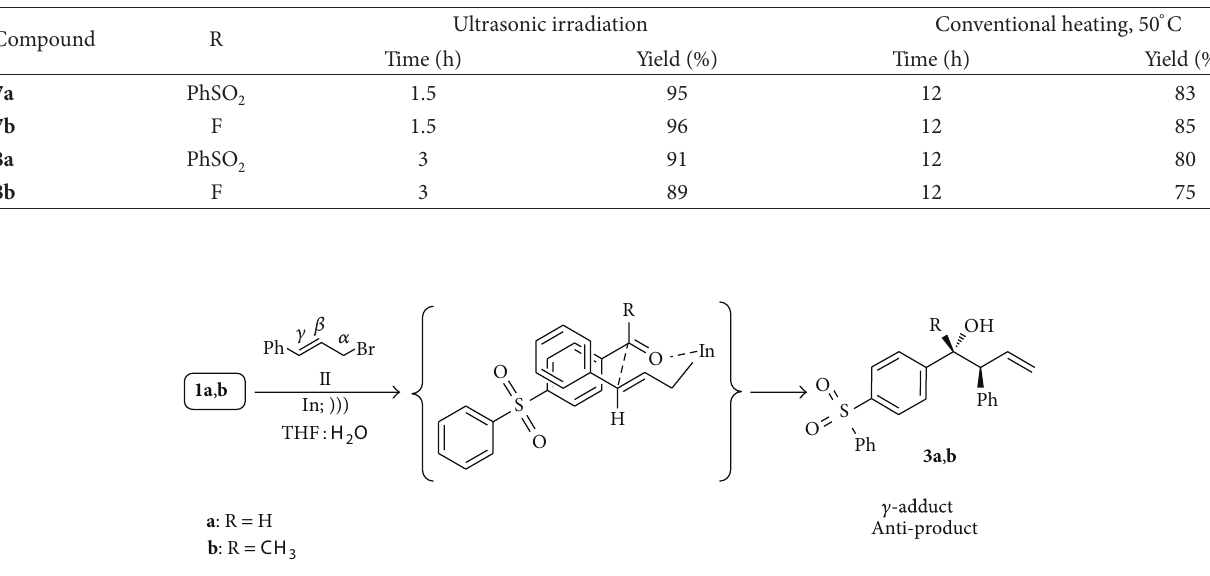
T 4: Synthesis of homoallylic alcohols by allylation of 6a,b with allylbromide (alcohols 7a,b ) and cinnamyl bromide (alcohols 8a,b ) as outlined in Scheme